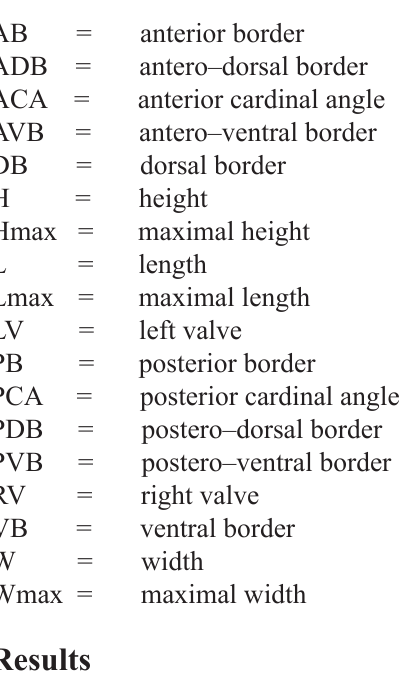
Fig. 3. Stratigraphic log of the Blue Snake Section and sampling points. Colours on stages and conodont zones correspond to the stratigraphic repartition of the 3 ostracod associations recognized in the present work. Orange: Association A. Grey: Association B. Green: Association